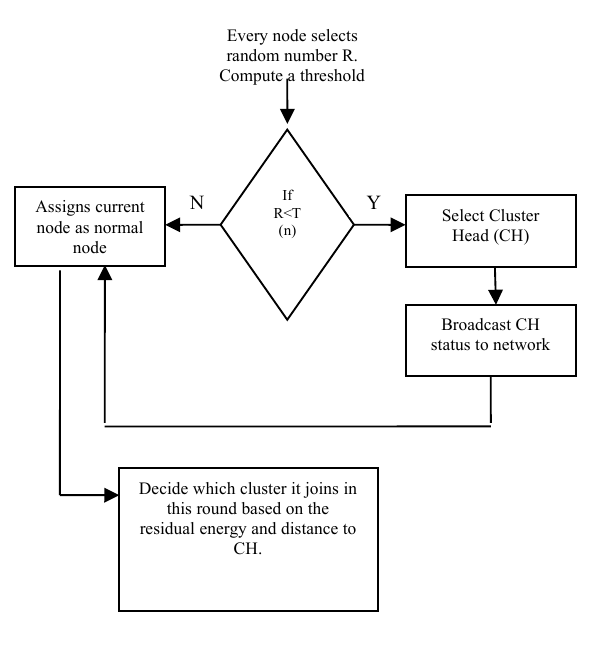
Figure 1. Setup phase Algorithm for MOD-